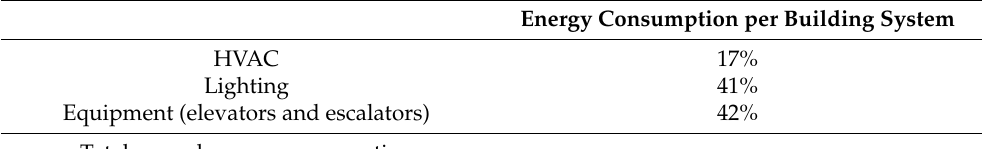
Table 2. Breakdown of the annual energy consumption of the case study’s main building